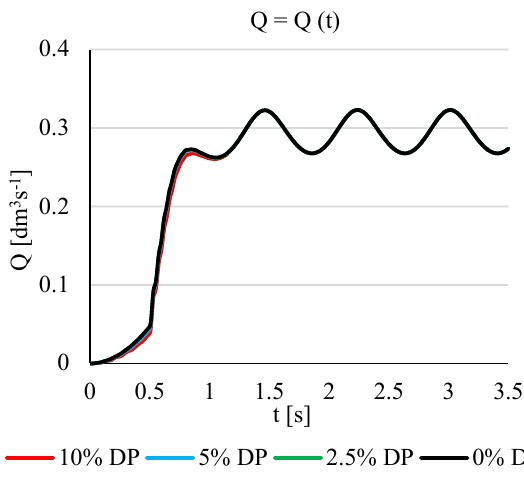
Fig. 4 Flows in the flexible tube with different fraction of DP